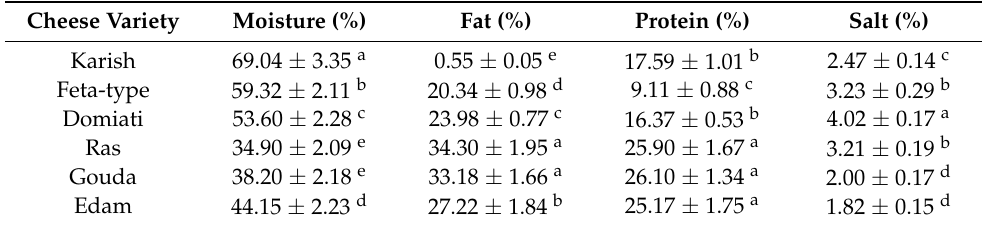
Table 2. Gross chemical composition of the different types of cheese. Cheese Variety Moisture (%) Fat (%) Protein (%) Salt (%) Karish 69.04 ± 3.35 a 0.55 ± 0.05 e Feta-type 59.32 ± 2.11